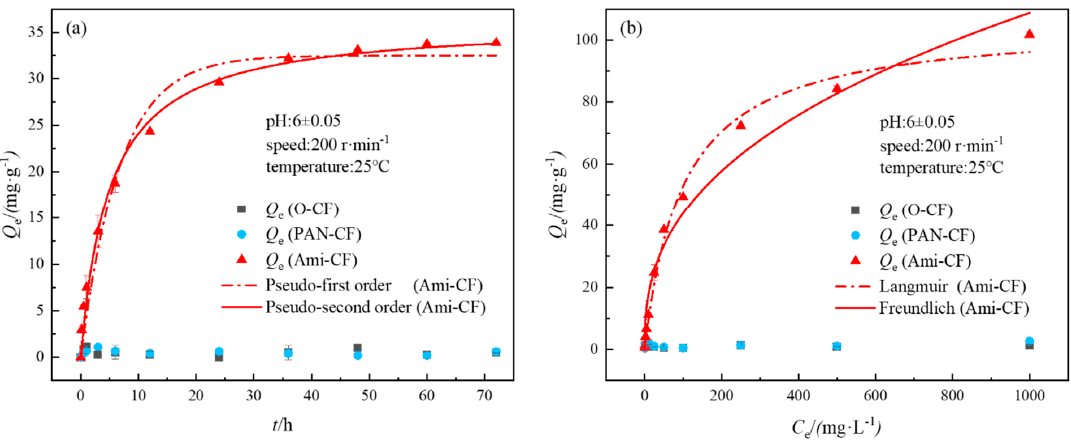
Figure 3. Adsorption kinetics ( a ) and adsorption isotherms ( b ) of Cr (VI) onto different carbon felts. Langmuir and Freundlich isotherm models are often used to reveal the interaction mechanism between heavy metal ions and adsorbents. Among them, the Langmuir model assumes that metal ions occur at a uniform interface through monolayer deposition. In contrast, the Freundlich isotherm model describes adsorption at a non-uniform inter- face [32]. The adsorption isotherms of Cr (VI) on different carbon felt electrodes are shown in Figure 3b. Due to the lack of effective adsorption sites, the saturated adsorption capacity of O-CF and PAN-CF on Cr (VI) is only 1.99–2.71 mg · g − 1 , whereas that of the Ami-CF-containing amidoxime group on Cr (VI) can reach 101.73 mg · g − 1 . It is 2.1–5.5 times the saturated adsorption capacity of biochar, oxidized composite materials and other ad- sorbents reported in the literature (Table S3) [30,38,39]. The fitting coefficient R 2 of the Langmuir model for Ami-CF adsorption of Cr (VI) is 0.992, whereas that of the Freundlich model is 0.968 (Table S2). Therefore, the Langmuir model is more suitable for describing Ami-CF adsorption of Cr (VI). This indicates that the adsorption behavior of Cr (VI) on Ami-CF is mainly a single-layer adsorption reaction [34]. The infinitesimal number R L is commonly used to judge whether the adsorption process is conducive to its occurrence, and its expression is shown in Equation (7).